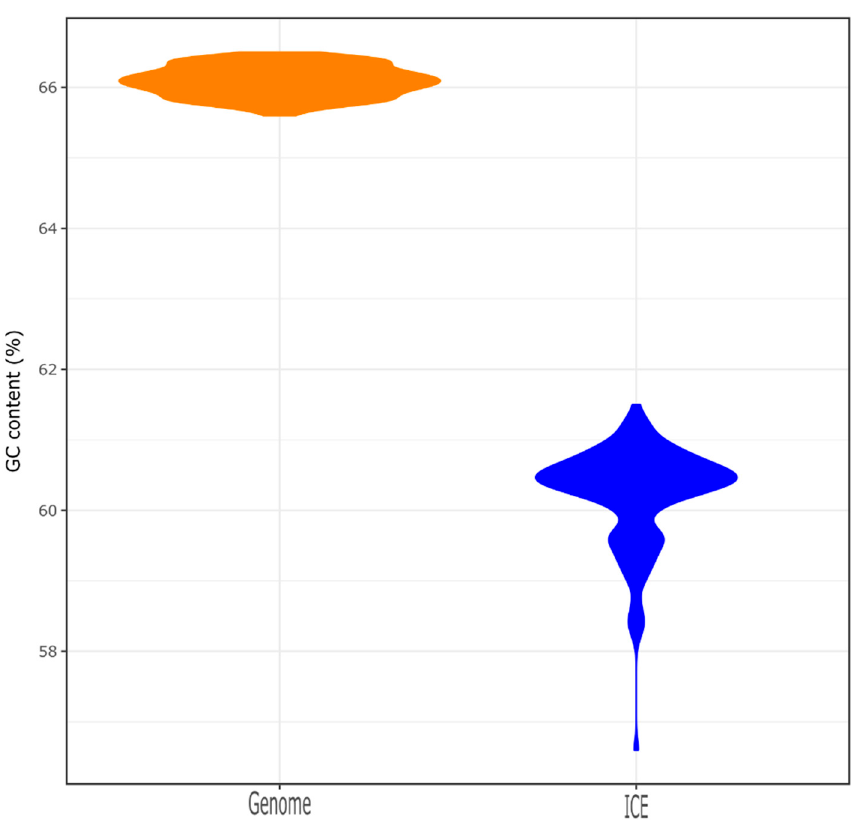
Figure 2. Distribution of the GC content of the chromosomes and integrative and conjugative elements (ICEs).